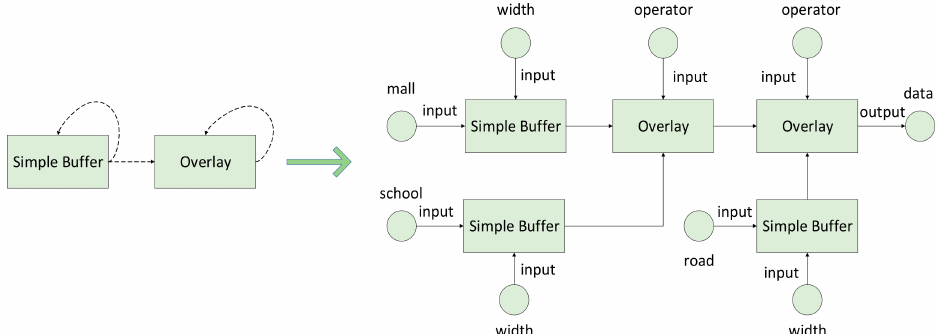
Figure 10. Service chain of urban housing selection. The left part of the figure is the subnet that includes Simple Buffer service and Overlay service in SR-QoS-GSW, and the right part is the urban house selection service chain based on the subnet.